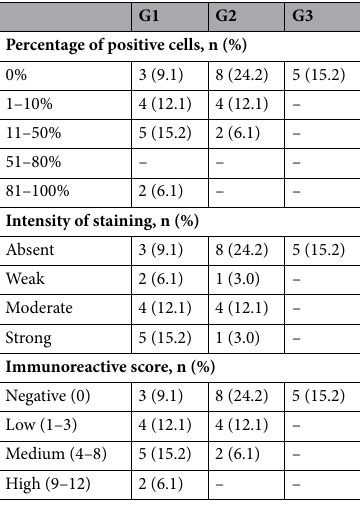
Table 2. Relationship between the grading and immunostaining